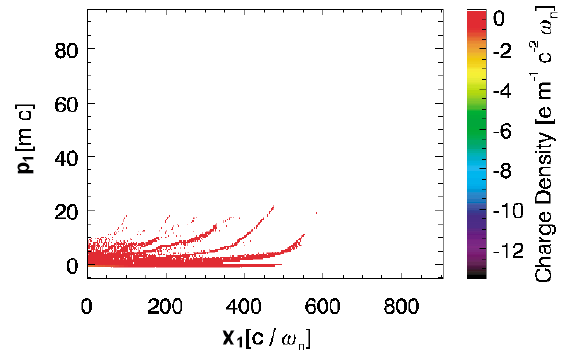
FIG. 3. (Video) The electron density in the plane of the simu- lation shortly before the laser leaves the plasma almost at the end of the density downramp. The laser propagates to the right. The marked group of electrons gets only at this time trapped by transverse wave breaking and then accelerated briefly until the laser and the accelerated electrons leave the plasma. The po- sition of the marked electrons is about 120 m m away from the plasma boundary. Note that the x 1 axis and the x 2 axis of the plot use slightly different scales. See video 3 for the dynamic development of the electron